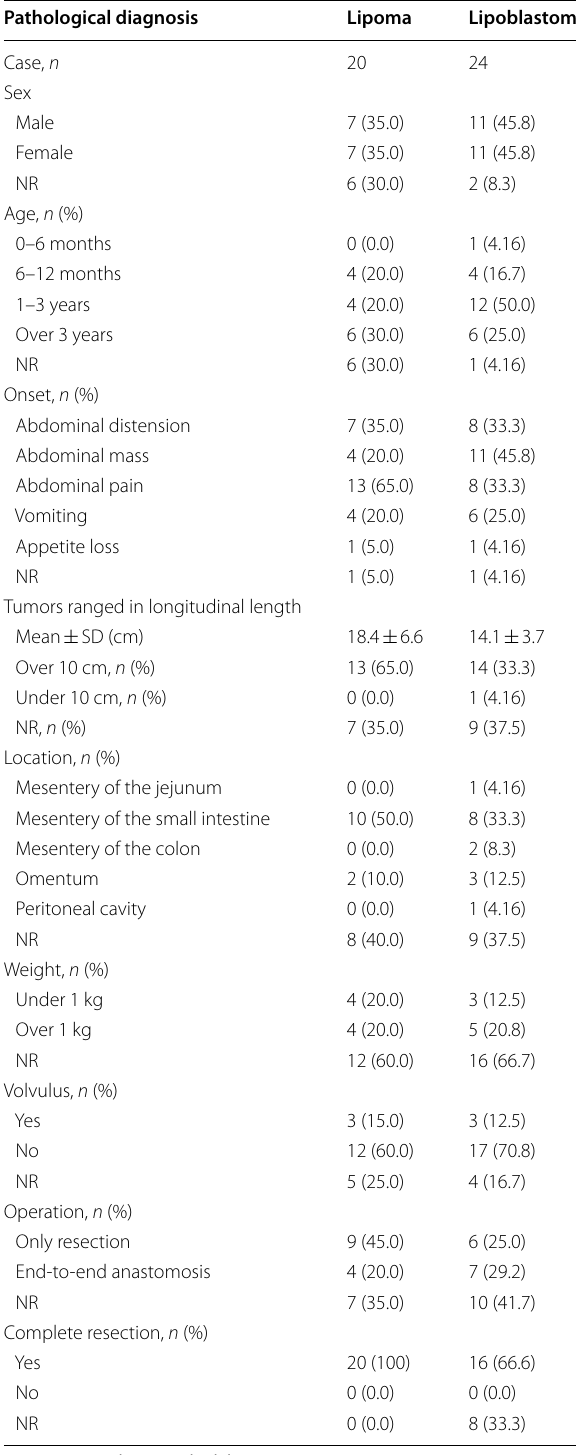
Table 1 Summarized cases of lipoma and